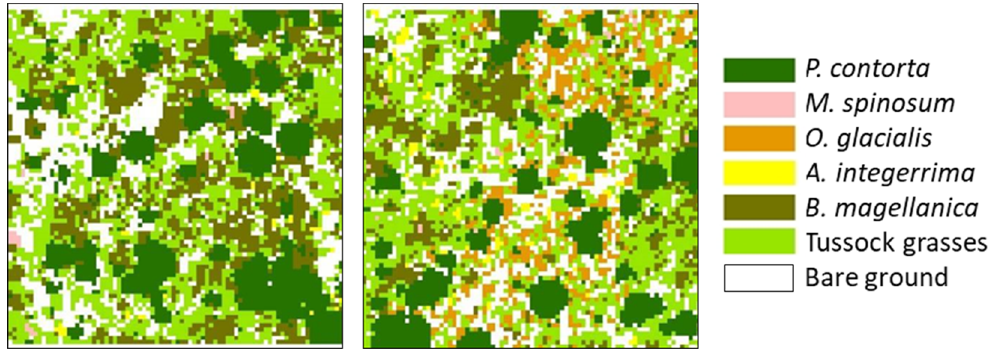
Figure 6. Ground cover types represented in the two areas of the sampling plot: Pinus contorta (22.5% and 18.9%), B. magellanica (30.8% and 16.2%), Tussock grasses (53.7% and 58.1%), bare ground (69.9% and 74.8%), Acaena integerrima (1% and 1.8%), Oreopolus glacialis (0.1% and 12.8%), and Mulinum spinosum (0.5% and 0.7%). Table 1. Morphological attributes of Pinus contorta individuals sampled in the invaded area. Height Class n Height (cm) DCH * (mm) Crown Diameter (cm) Height Class < 10 cm